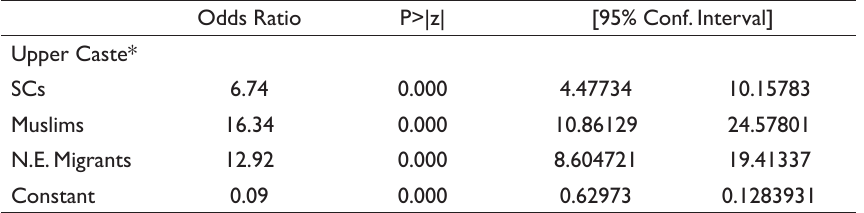
Table 11. Logistic Regression